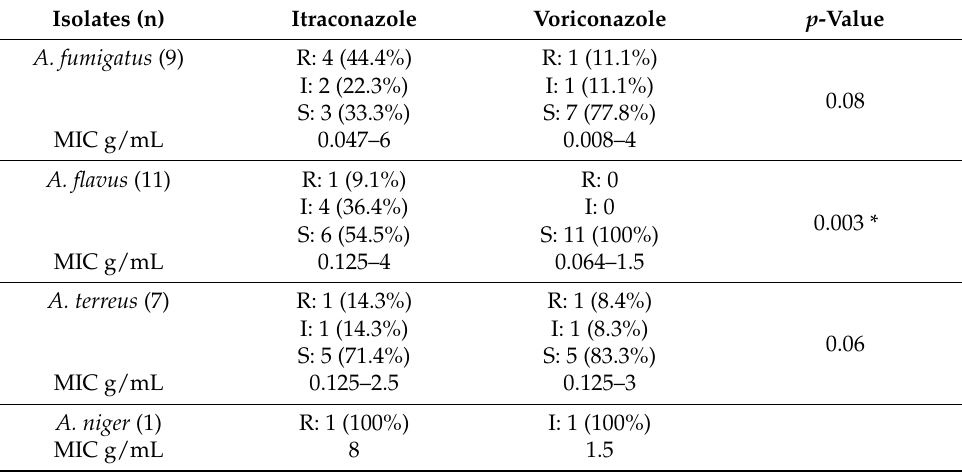
Table 4. Antifungal susceptibility patterns and MIC of Aspergillus spp. using the E test. Isolates